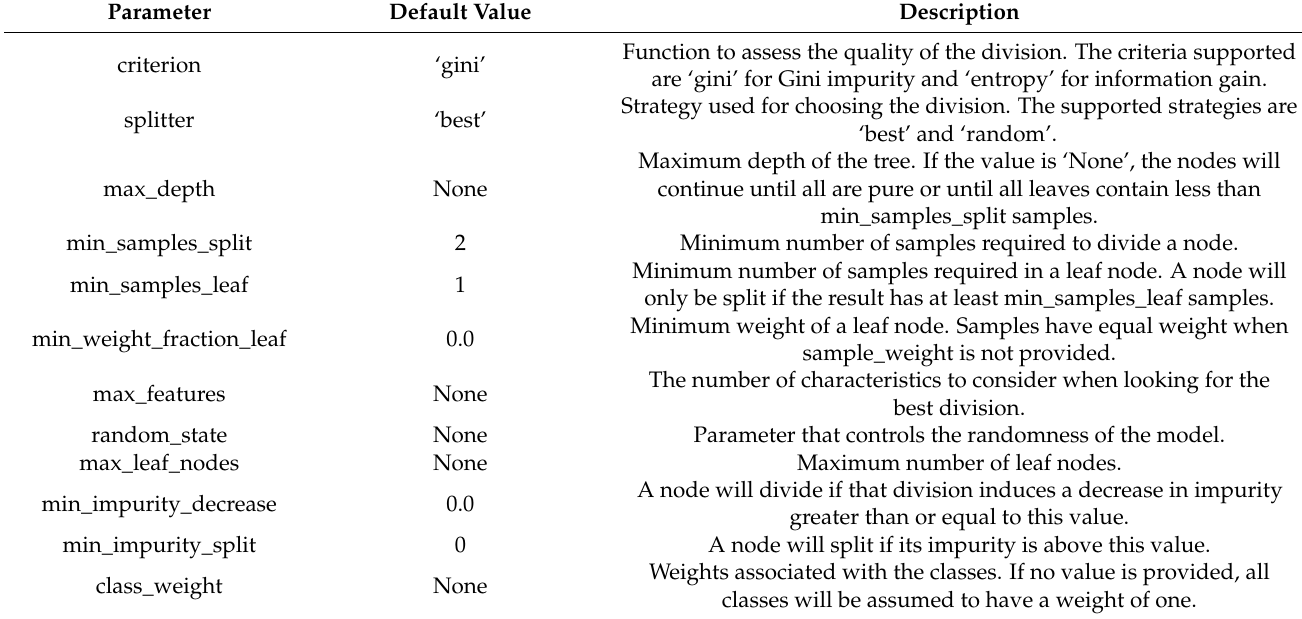
Table 2. Hyper-parameters for classification decision trees in scikit-learn